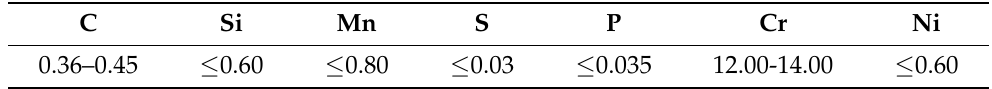
Table 1. Main components of 40Cr13